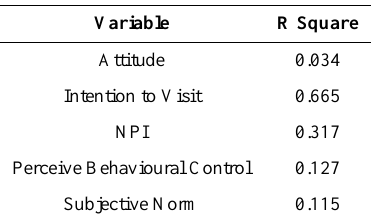
Table 4. Explanatory Capability.